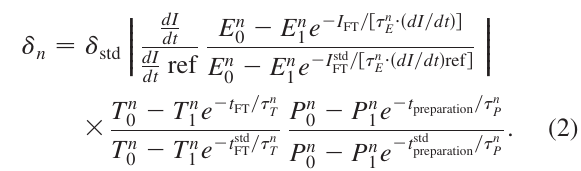
FIG. 6. (Color) (a) The normalized b 3 decay amplitude and the FiDeL model in red vs the precycle flattop current. (b) The normalized b 3 decay amplitude and the FiDeL model in red vs the precycle ramp rate. Note: The labeling in the key denotes the magnet number and aperture. The decay amplitude is normalized to I max ¼ 11 850 A . I FT ¼ 0 denotes no precycle, i.e., a cycle directly after a quench.